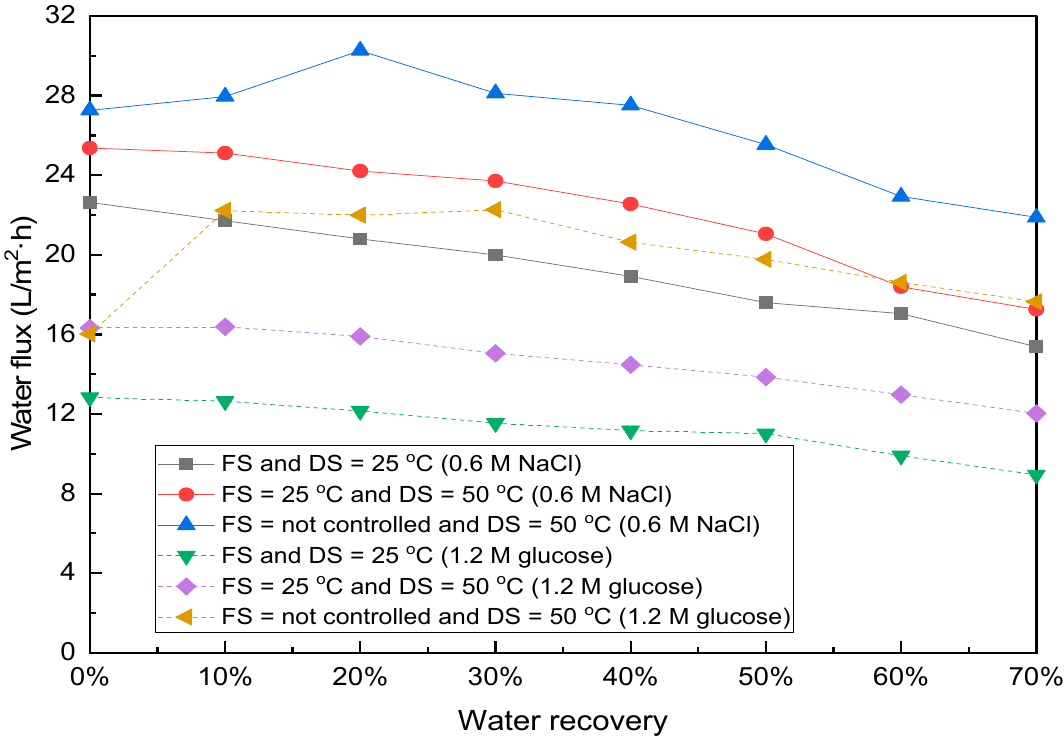
Figure 4. Water flux at different FS and DS temperatures during the TFC hollow fiber FO filtration of synthetic municipal wastewater until a 70% water recovery